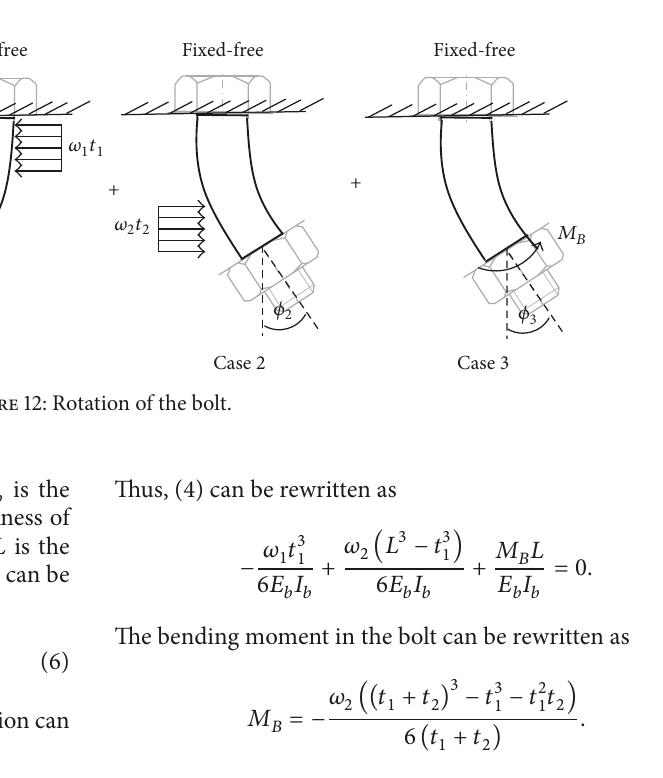
Figure 11: Shear deformation of cantilever beam.